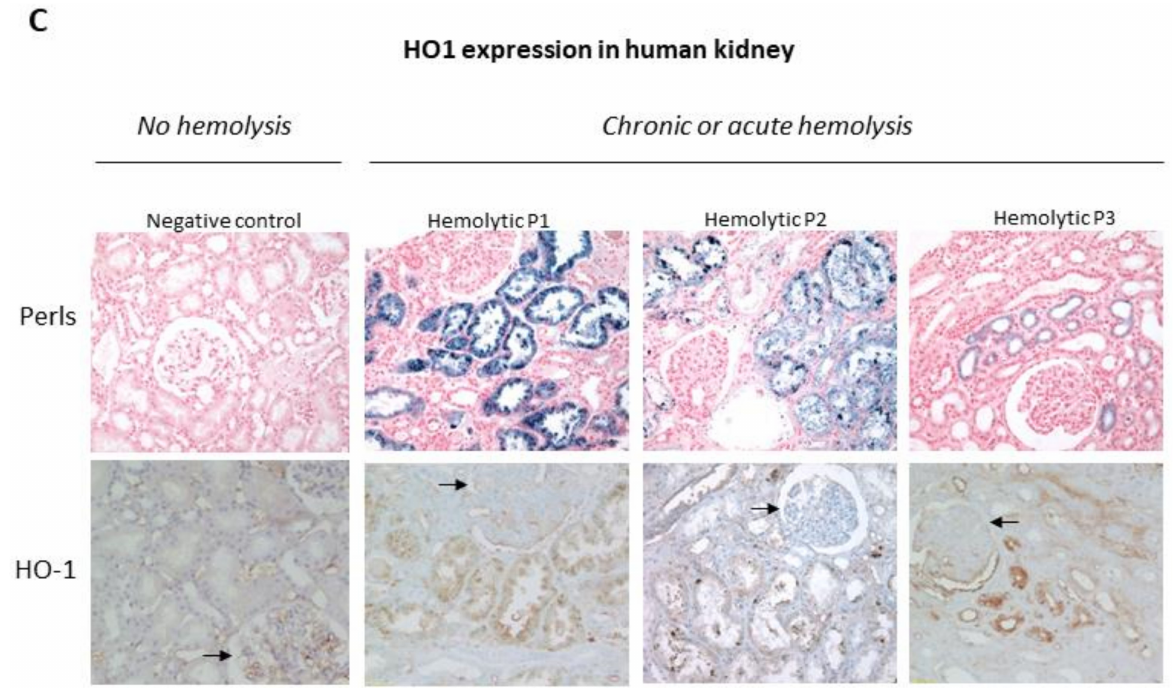
Figure 2. Renal expression of HO1 (adapted from [27]). HO-1 staining in mouse kidneys in IF ( A ) and IHC ( B ). A- HO-1 (red) staining, vWF (green) staining, and colocalization on frozen kidney (x15) sections of mice, injected with PBS (upper panel) or heme as HO1 inducer (lower panel), studied by IF ( A ); B- HO-1 staining appears in brown on frozen kidneys sections of mice treated with PBS or heme. ( C ) HO-1 expression in human kidneys: hemosiderin deposits in human kidney biopsies evaluated by Perls’ coloration and HO-1 (brown) staining were performed by IHC. A normal protocol, kidney allograft biopsy performed 3 months after transplant was used as a negative control. Patients 1 and 2 suffered chronic hemolysis associated with prosthetic heart valves, and patient 3 carried the C3 mutation complicated with atypical hemolytic uremic syndrome (arrows indicate